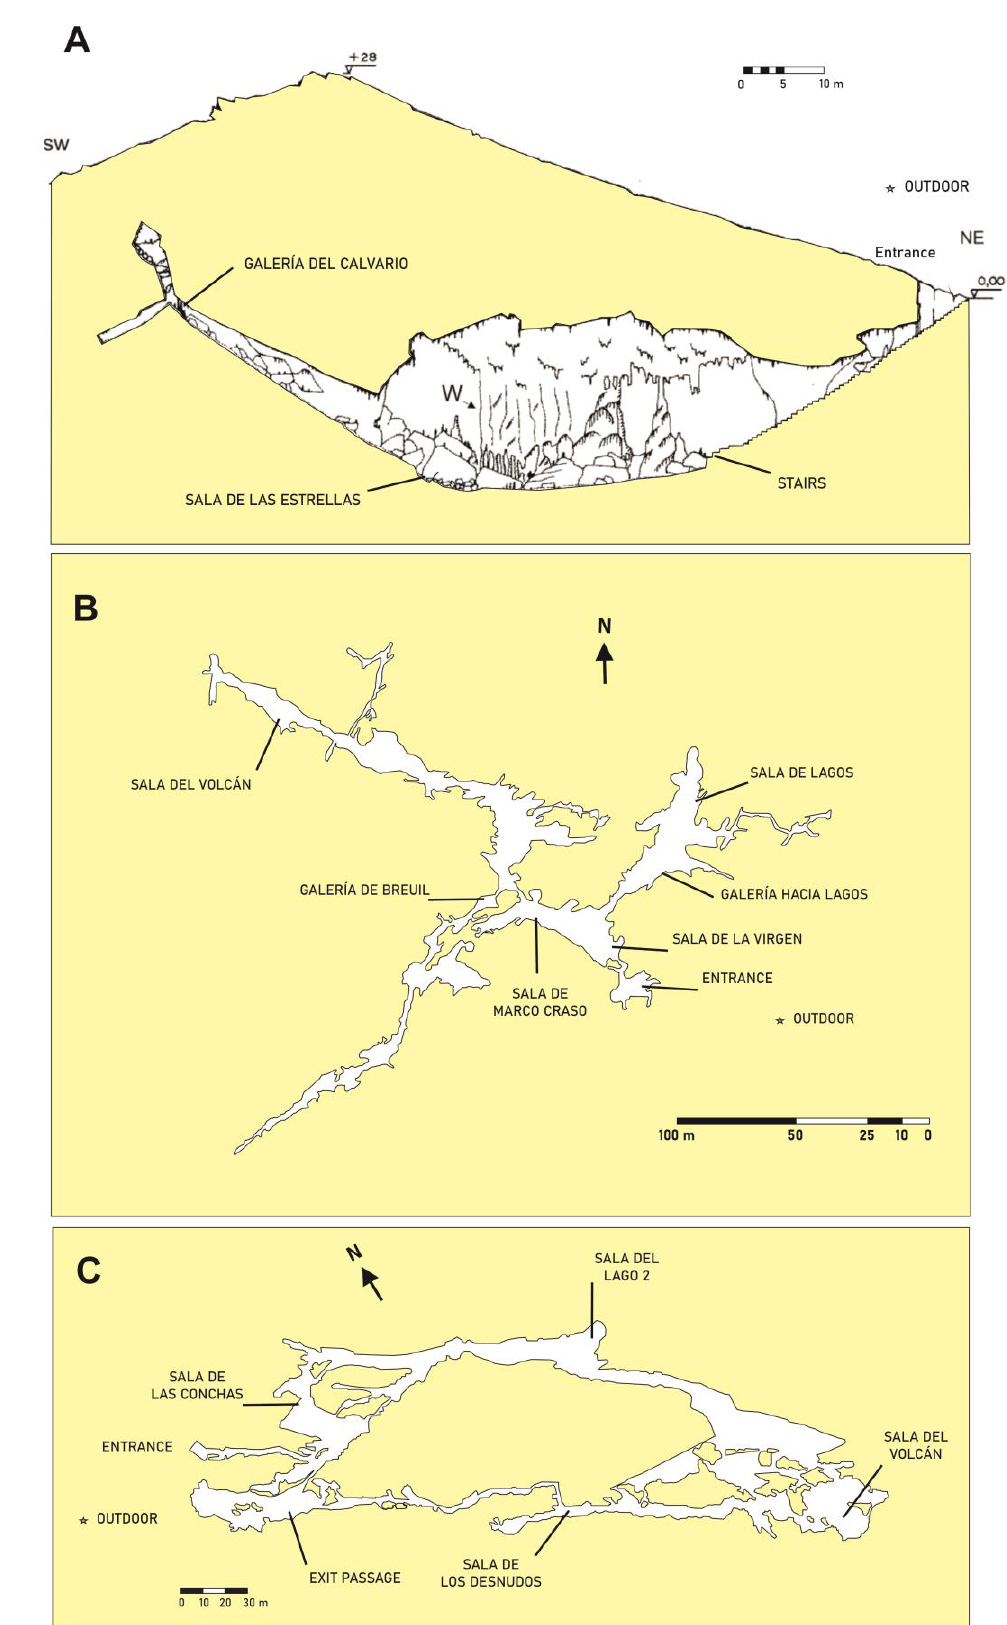
FIGURE 1: Map and sampling locations in the caves. (A) Cueva de Ardales ; (B) Cueva del Tesoro ; (C) Gruta de las Maravillas